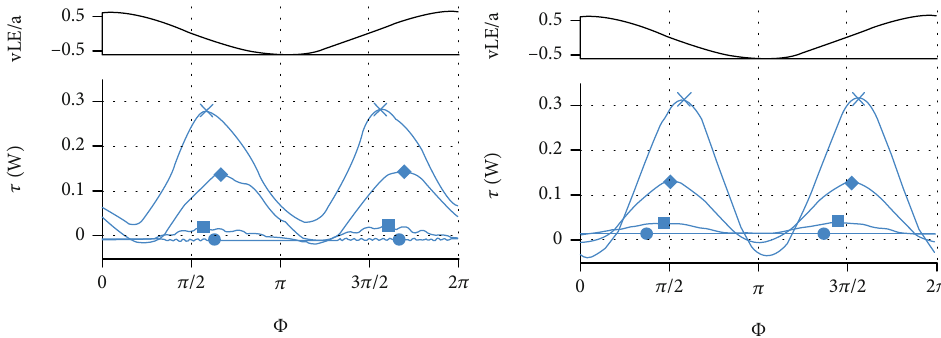
. (c, d) Net thrust (c) LE